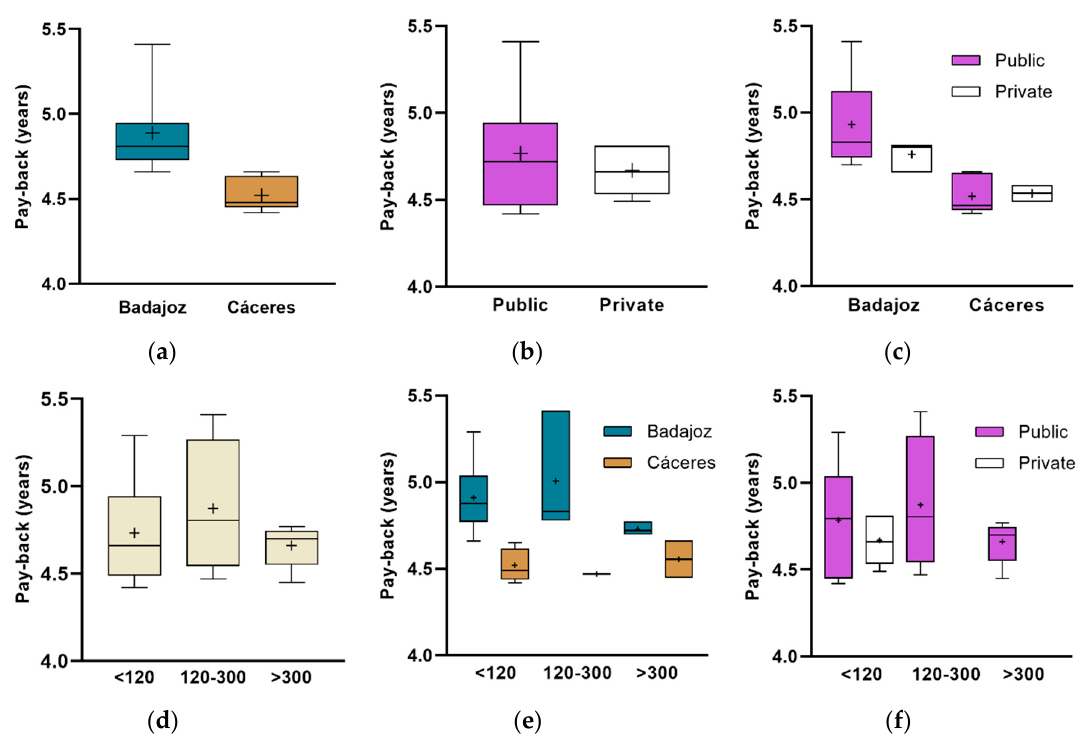
Figure 9. Payback for solar contribution of 70% classified by ( a ) province, ( b ) management, ( c ) both of them, ( d ) NB, ( e ) NB and province and ( f ) NB and type of management (there are not private hospitals in NB > 120 categories).